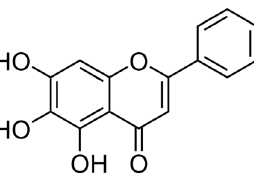
Figure 1. Chemical structure of Baicalein (Source: PubChem CID, 5281605). Relative to the colon, the gastric region and small intestine are better at absorbing baicalein. According to Biopharmaceutic Classification System (BCS) techniques, gut permeability steadily declined from the duodenal regions to the colonic part. Baicalein absorption in various gut regions could be subjected to passive transport processes and substantial metabolism, both in vivo and in vitro [32].